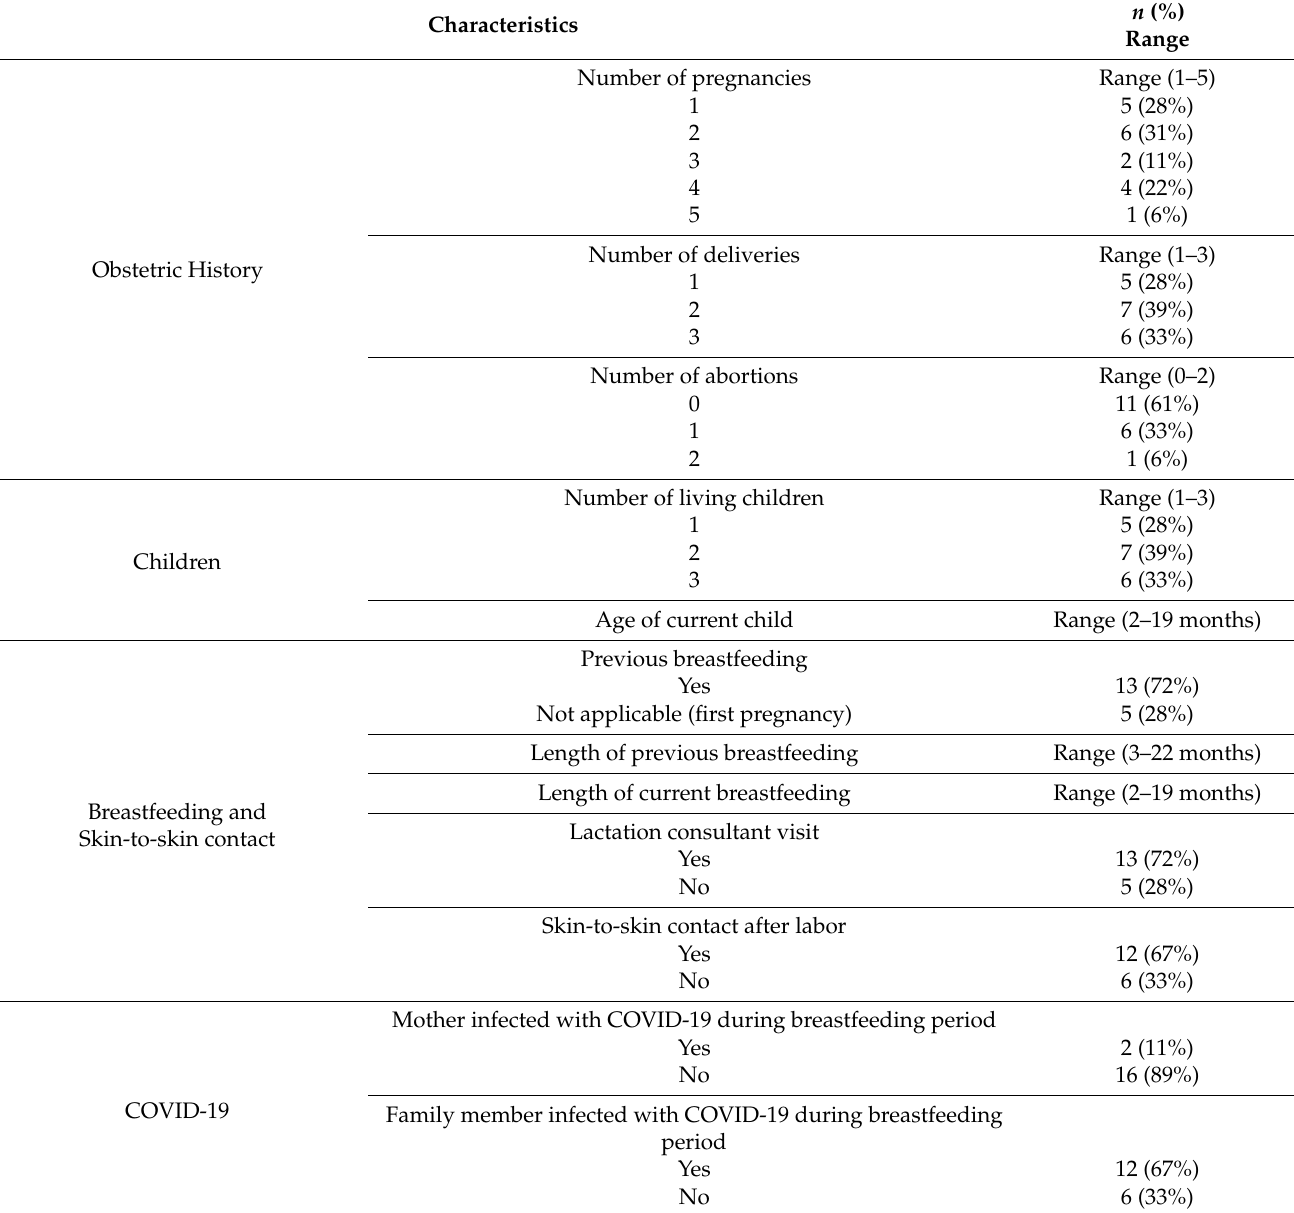
Table 1. Sociodemographic